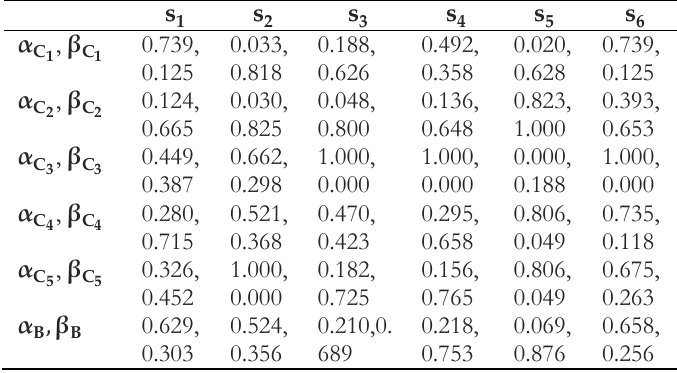
Table 6. Patterns of mineral fields in